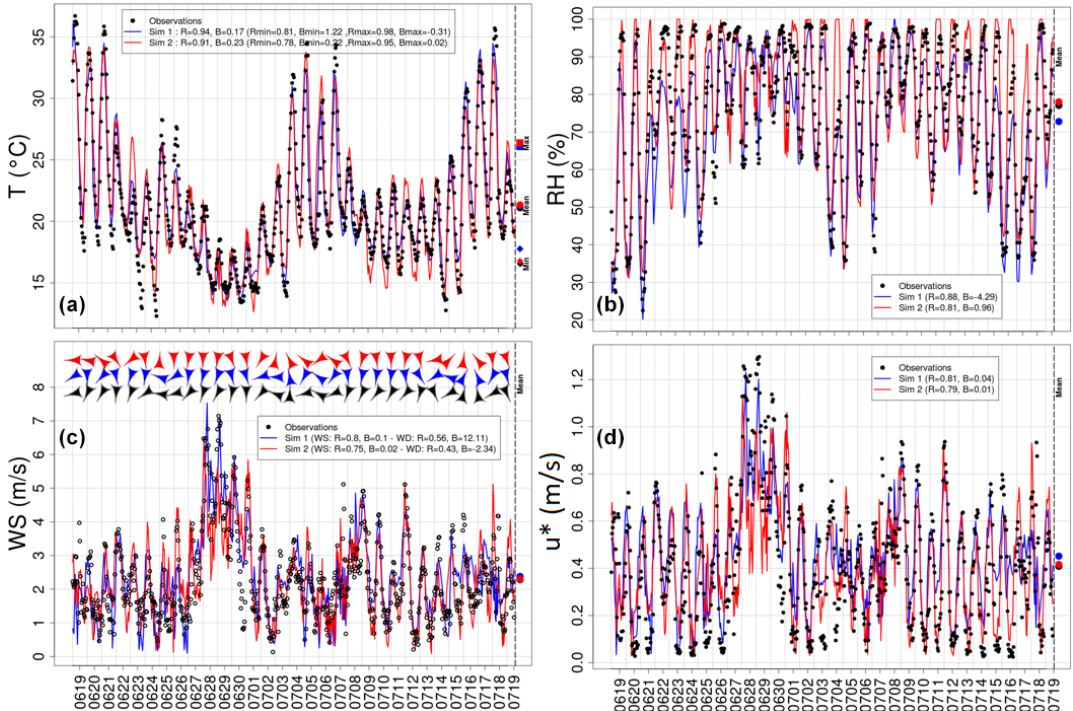
Figure 2. Meteorological comparisons for the two meteorological inputs. The blue series (SIM1) shows the ECMWF simulations, and the red series (SIM2) shows the WRF outputs. Statistical information is provided in the legend for each figure ( R is the correlation coefficient, and B is bias (simulation–observation)). The name of each parameter is written on the side of each panel, and the points on the right side of each panel show the average data for each series. The comparisons are performed for the 1km domain and for the Salles-Bilos measurement site. The comparisons are performed at surface level. Panels (a) – (d) show temperature ( a , marked as T , in ◦ C), relative humidity ( b , marked as RH, in %), wind speed and wind direction ( c , Ws is wind speed in ms − 1 , and directions are shown at the top of each day), and friction velocity ( d , marked as u ∗ in ms − 1 ). More information about all of the WRF simulations and the one that was chosen to be presented here (WRF3) is given in Sect.